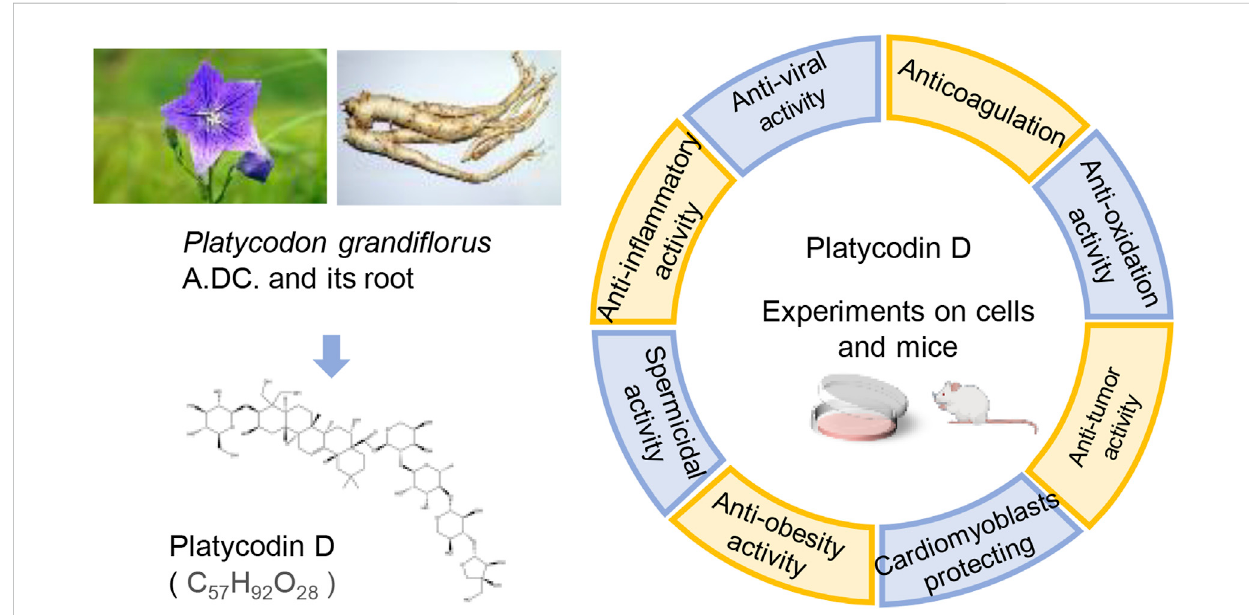
FIGURE 1 ThepharmacologicalactivitiesofPLD,oneoftheactiveconstituentsofPG.(TheleftpictureofPG,photographedby663highlandon3August2013, is under licensed by CC BY-SA 3.0. The right picture of PG root, photographed by Asfreeas on 9 November 2010, is under licensed by CC BY